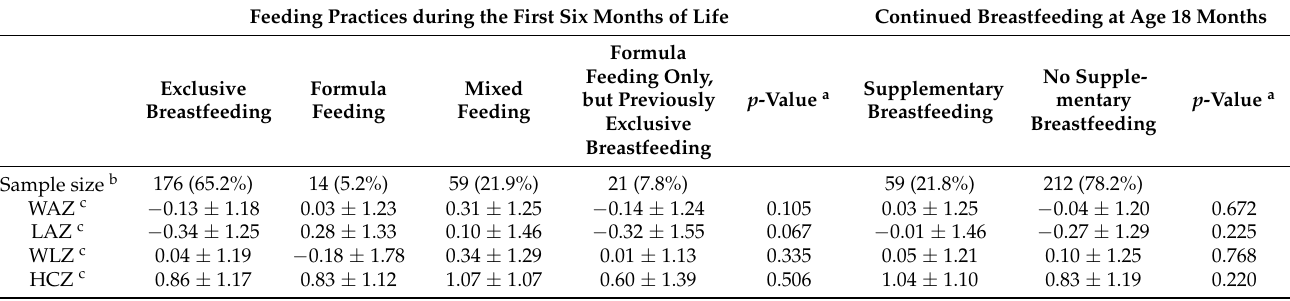
Table 5. Comparison of mean child growth indicators between breastfeeding